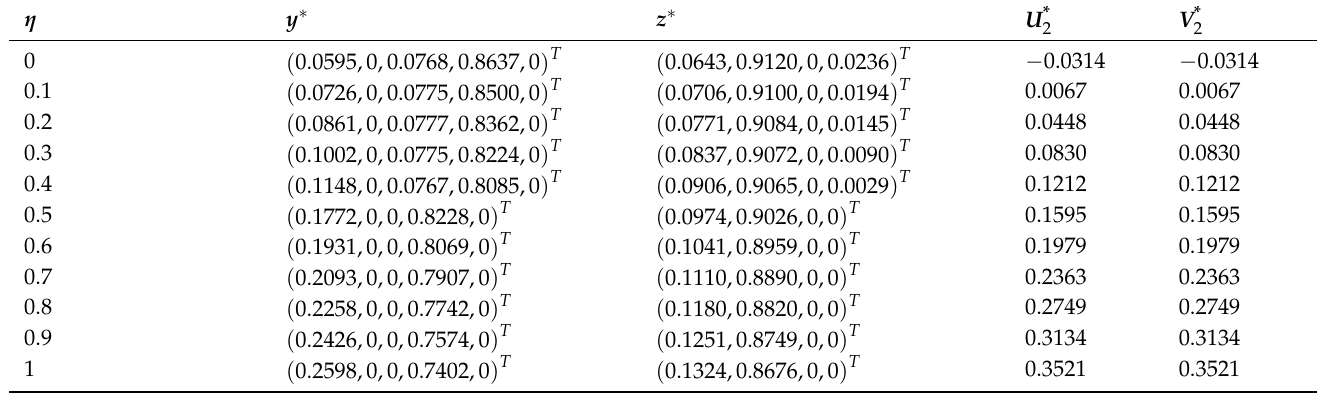
Table 3. Results obtained by using triangular fuzzy envelope for different values of η .